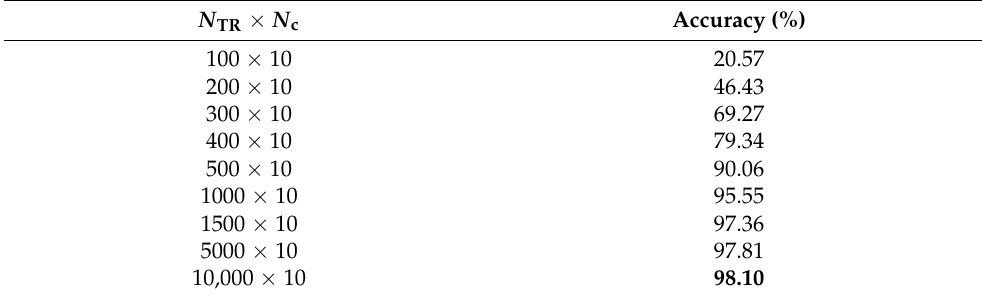
for testing with D 15 17, GAN